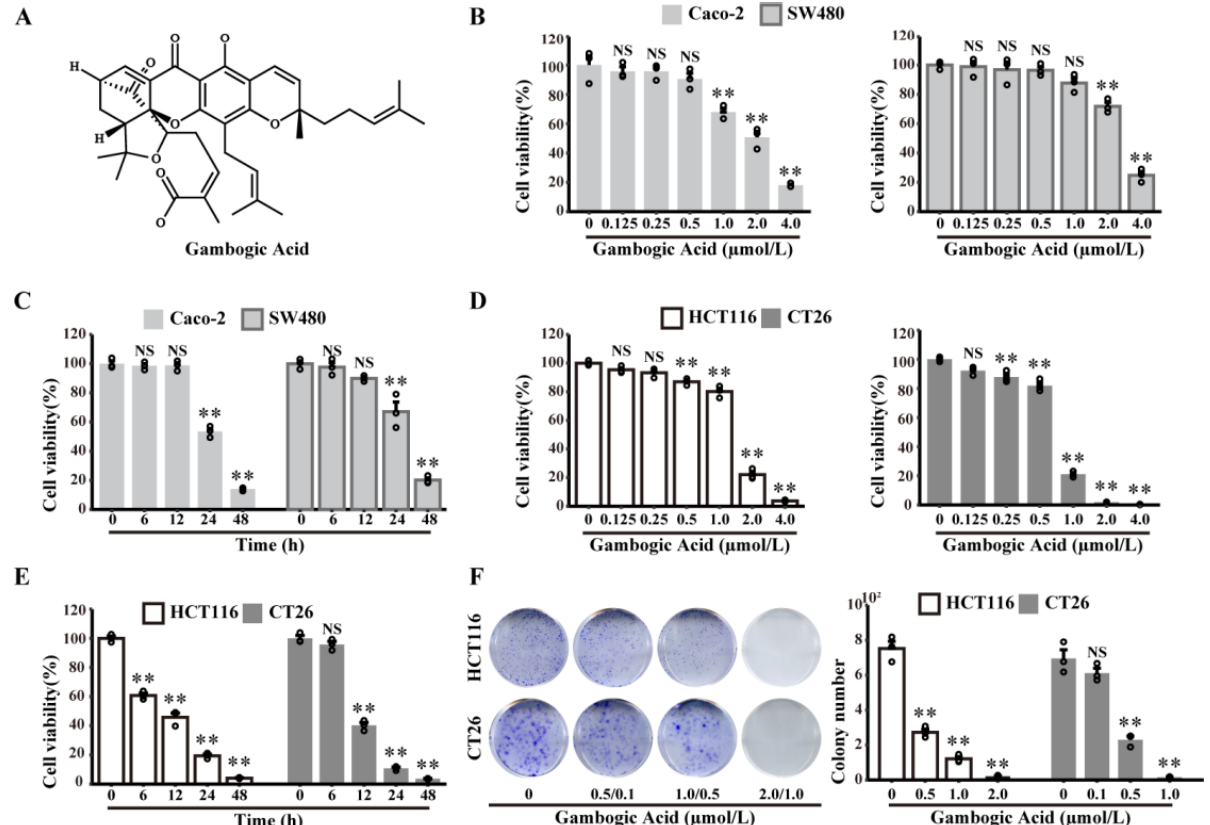
Figure 1. GA decreases Caco-2, SW480, HCT116, and CT26 cell viability in dose- and time-dependent manners. ( A ) Chemical structure of GA. ( B ) Caco-2, SW480, ( D ) HCT116, and CT26 cells were treated with GA (0 –4 μmo l/L) for 24 h, and cell viability was analysed by the CCK8 assay. ( C ) Caco-2 and SW480 cells were treated with GA (2 μmol/L) for different times, and cell viability was analysed by the CCK8 assay. ( E ) HCT116 and CT26 cells were treated with GA (2 μmol/L and 1 μmol/L, respectively) for different times, and cell viability was analysed by the CCK8 assay. ( F ) HCT116 and CT26 cells were treated with the indicated concentrations of GA and stained with crystal violet. The cells were exposed to 0.1% DMSO as control. All experiments were repeated three times, and results were expressed as mean ± SD. NS, not significant, ** p < 0.01 vs. control.